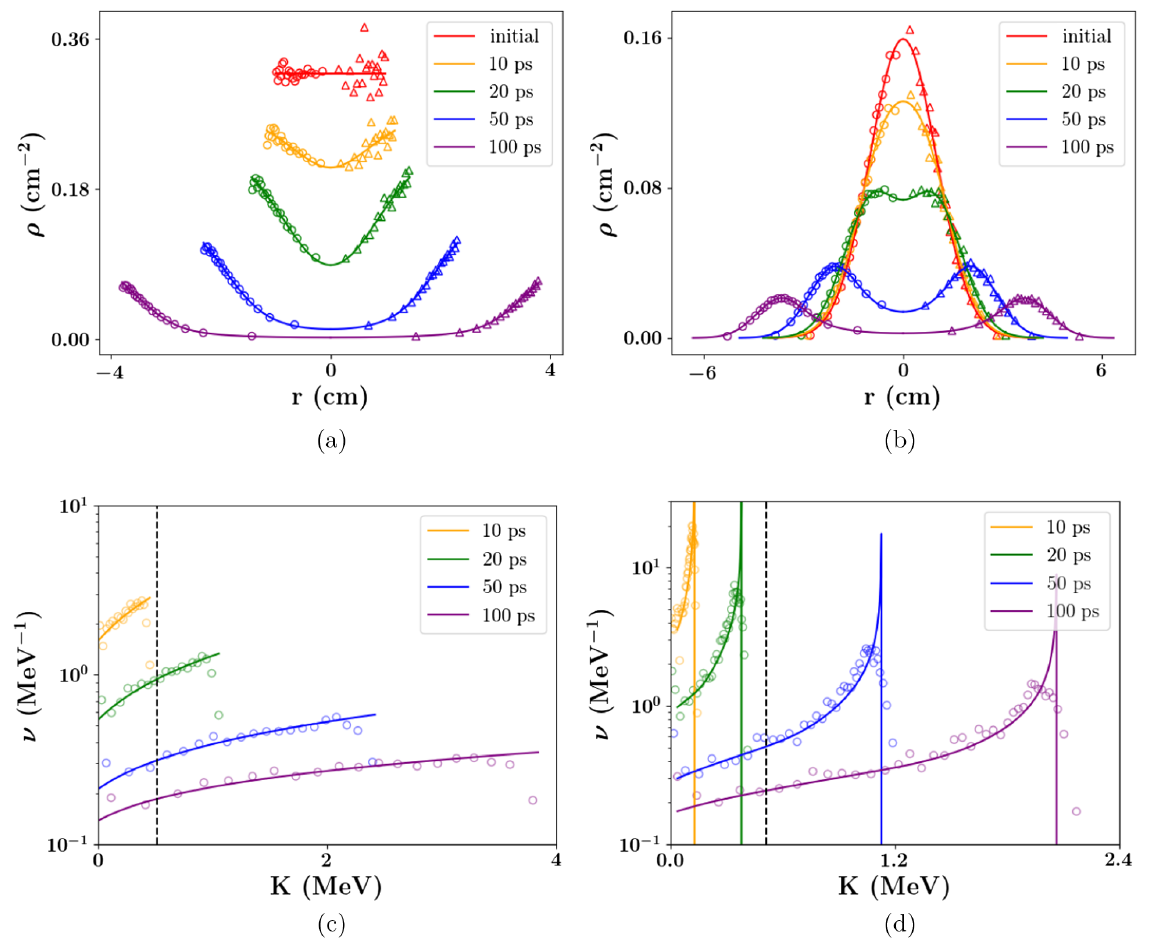
FIG. 5. Theoretical predictions (solid line), cylindrical M -shell simulations (hollow triangles – right), and PIC simulations using an EM solver (hollow circles – left) for (a,b) spatial and (c,d) energy density of (a,c) initially uniform and (b,d) initially Gaussian density at 5 different times for the cylindrically symmetric case. The initial energy distribution is not shown in (c,d) as it is a delta function. PIC simulations were analyzed using the middle 0.2 m from a simulation of a 2 m-long, 3D distribution of electrons with periodic